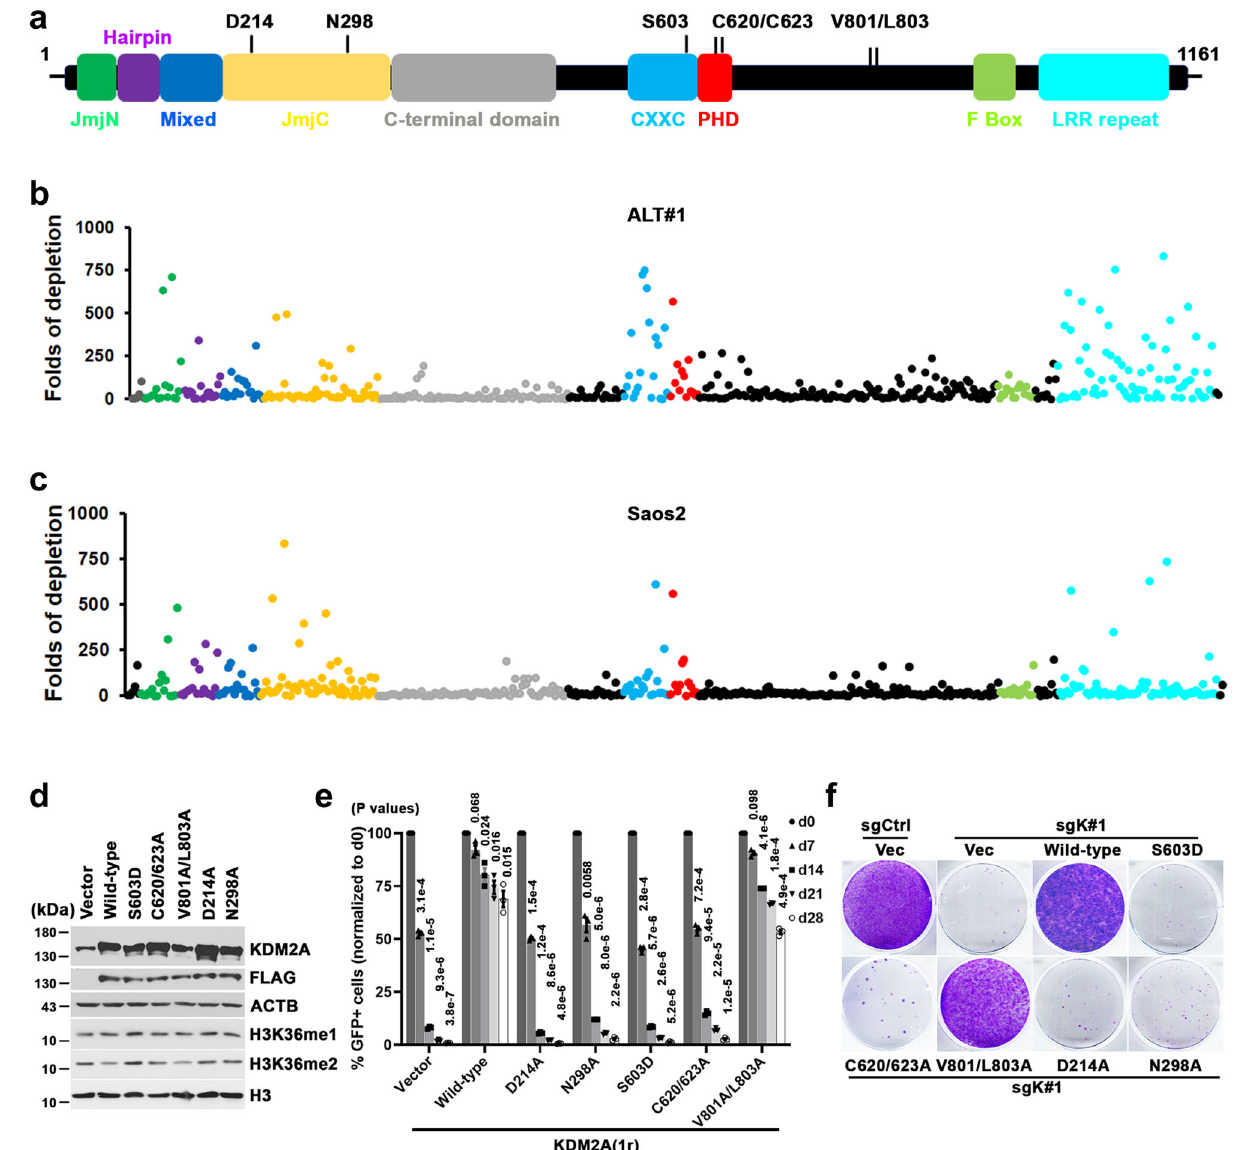
Fig.3|DNAbindinganddemethylaseactivitiesofKDM2Aarebothrequiredfor its ALT-supporting function. a Schematic of full-length KDM2A protein. The domains are labeled and color-coded. b , c CRISPR-based KDM2A tiling assay in ALT#1( b )andSaos2cells( c ).PlottedisthefoldchangesofsgRNAabundance(ratio ofstarttoendpoint)after16populationdoublingsinculture.x-axisshowstargeting sgRNAs and the domain location of each sgRNA within the KDM2A protein is indicated by colors; the y-axis shows the fold changes of each targeting sgRNA following the culture period. d Western blot analysis of KDM2A, Flag, and ACTB in whole-cell lysates prepared from Saos2 cells transducedwith